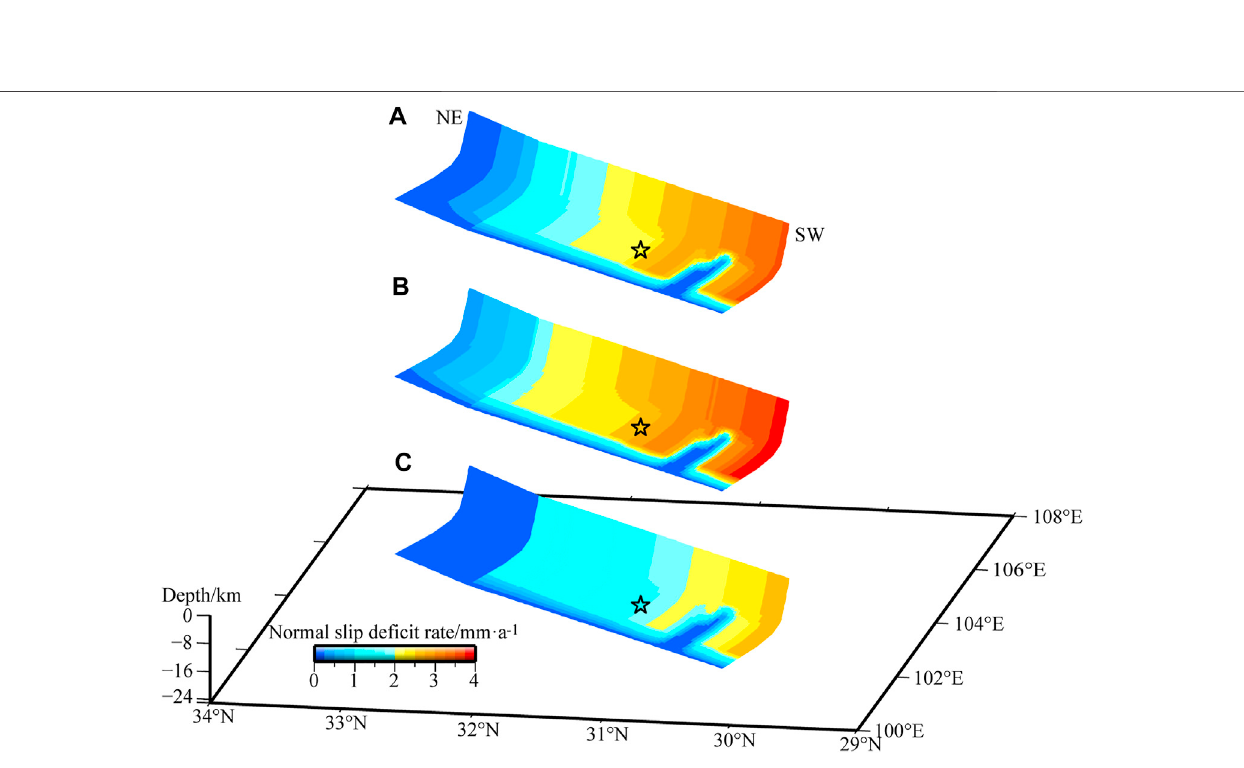
Frontiers in Earth Science |